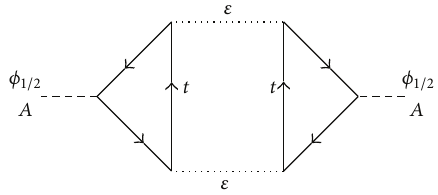
Figure 14: Sample diagram contributing a finite term to Σ 𝜙 and so forth when the infrared divergence are regulated through a small external momentum or a finite 𝜀 -scalar